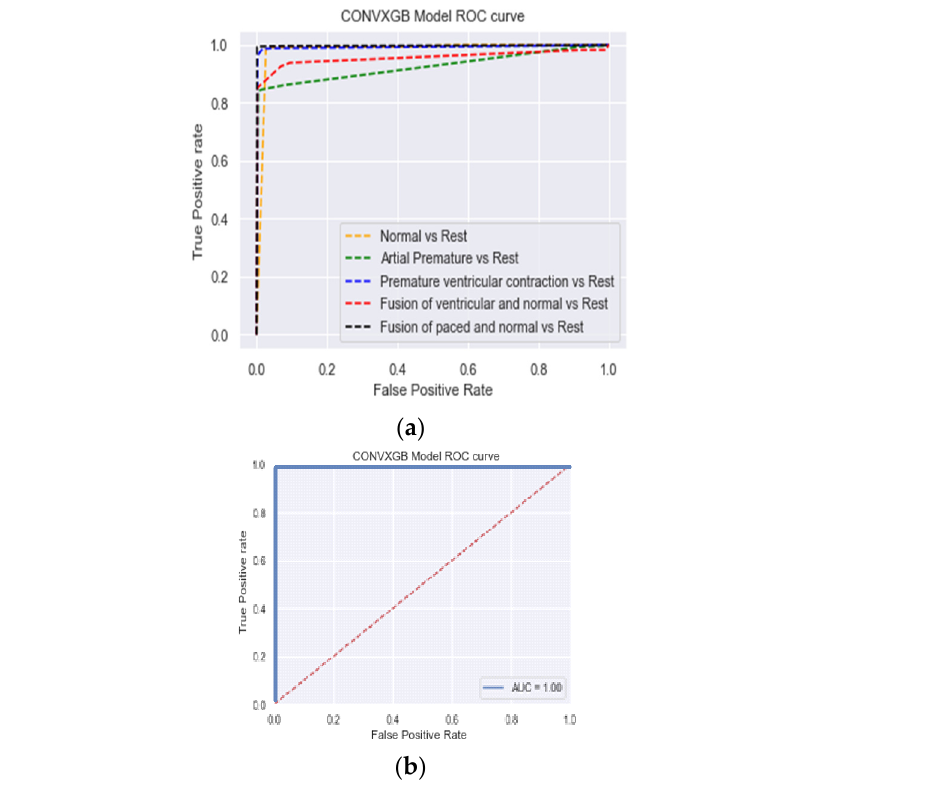
Figure 7. AUC of the ConvXGB model for ( a ) MIT-BIH and ( b ) PTB.